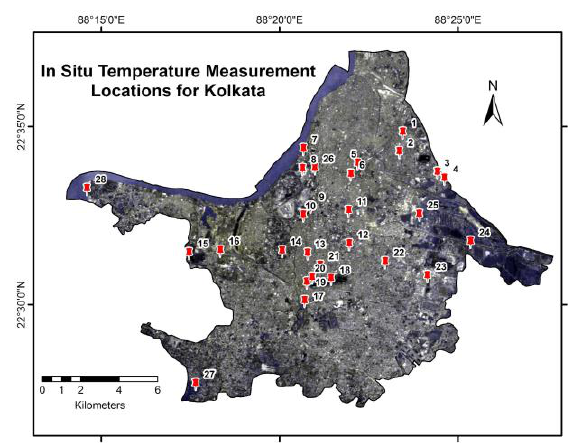
Figure 4. Distribution of locations in Kolkata for in-situ temperature measurement at